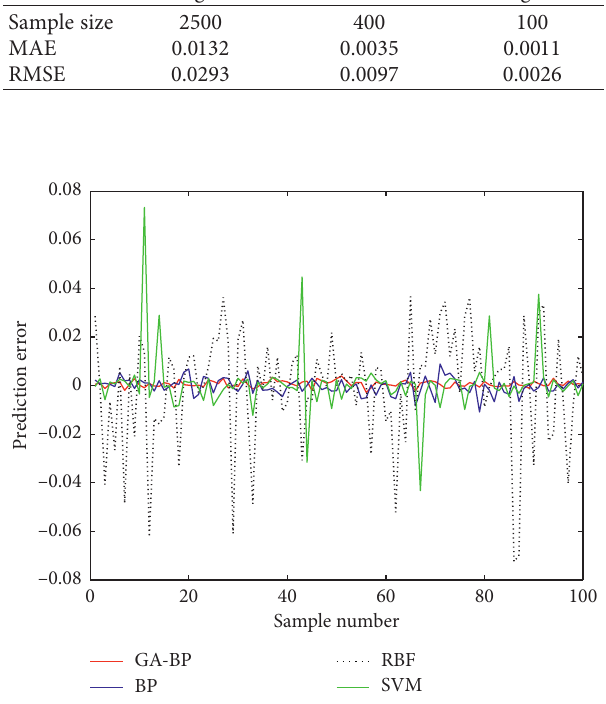
Table 4: Design specifications of GA-BP neural network model. GA-BP